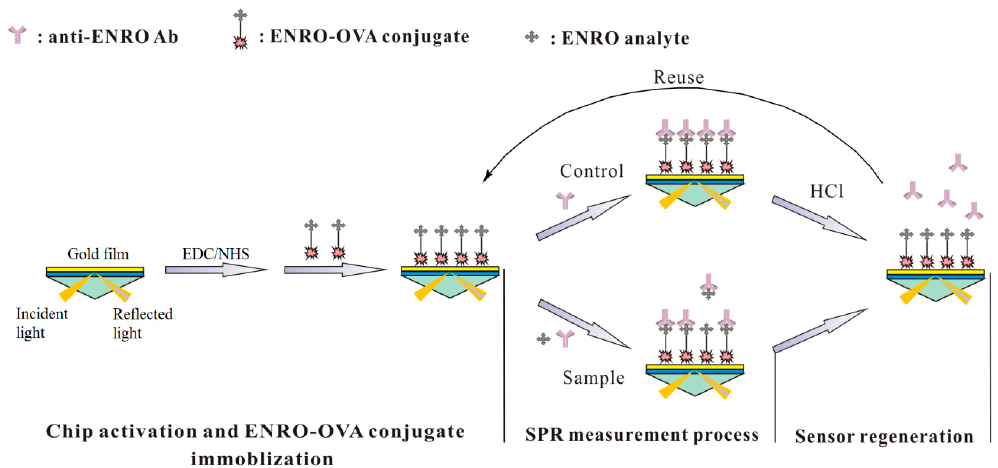
Figure 1. Schematic diagram of the SPR immunosensor for ENRO detection.